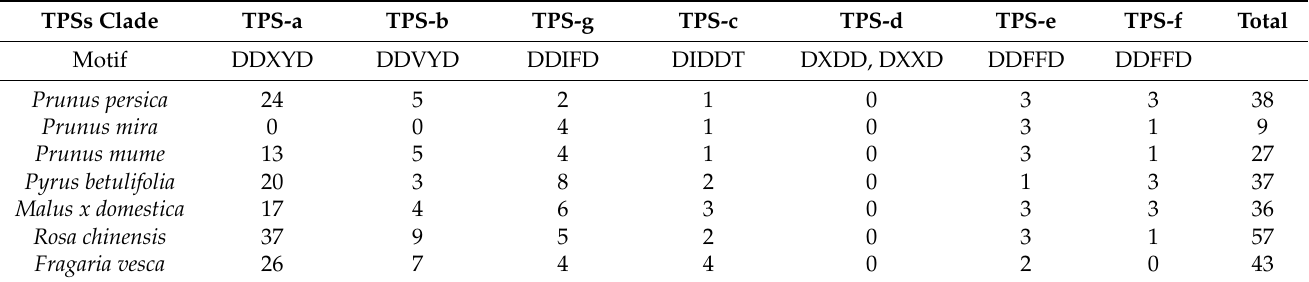
Table 2. Numbers of complete TPSs with both domains from Rosaceae species that were used for the phylogenetic tree of Figure 3.